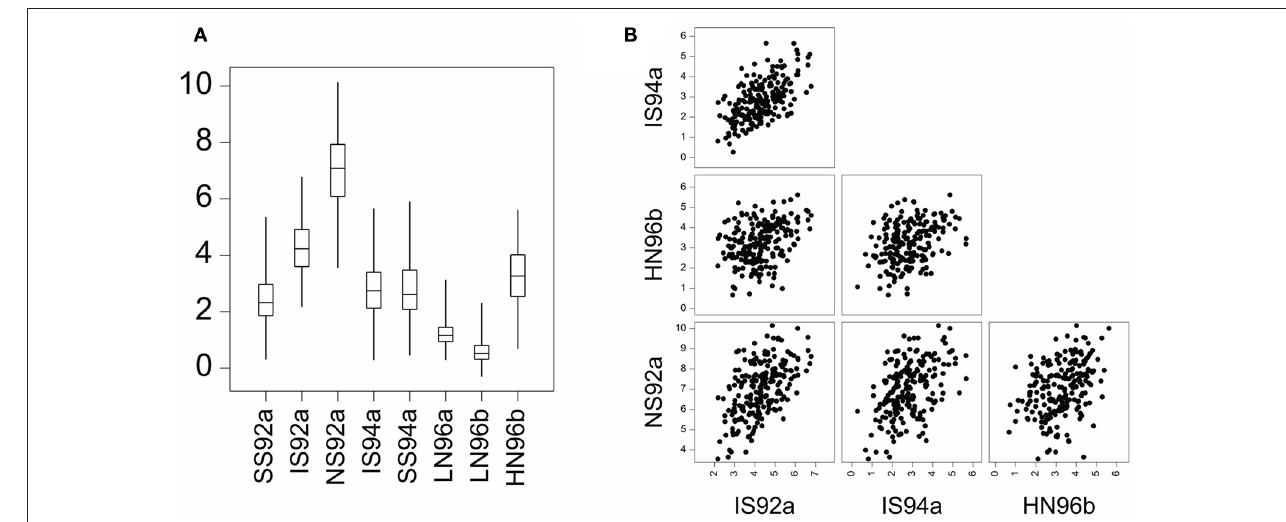
FIGURE 2 | (A) Boxplot for yield of a maize F2 population in eight environments displaying total range, interquartile range (box) and median (line). Environment names are coded as: LN, low nitrogen; HN, high Nitrogen; SS, severe water stress; IS, intermediate water stress; NS, no water stress.